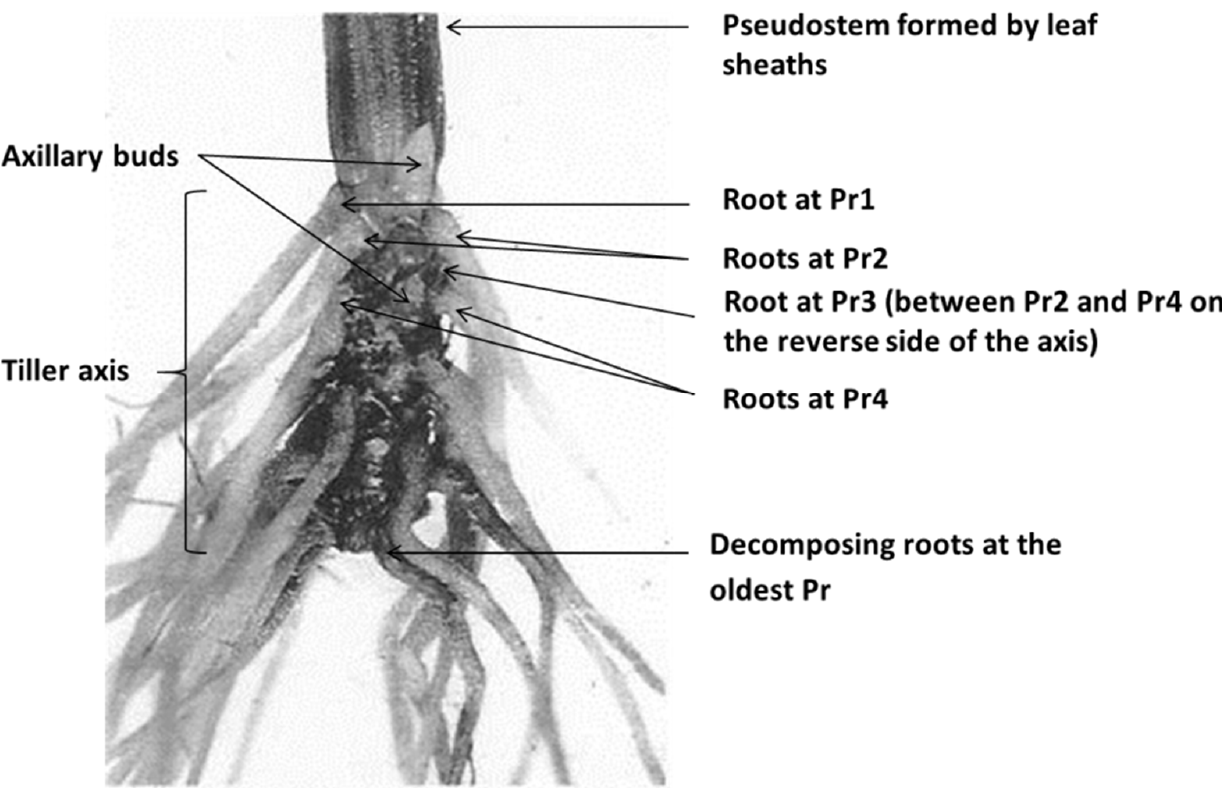
Figure 5. Axis of a perennial ryegrass tiller showing white younger roots at root bearing phytomers (Pr), Pr1–Pr4 and decay and decomposition of roots at the oldest Pr. The root bearing phytomers collectively make up the tiller axis.